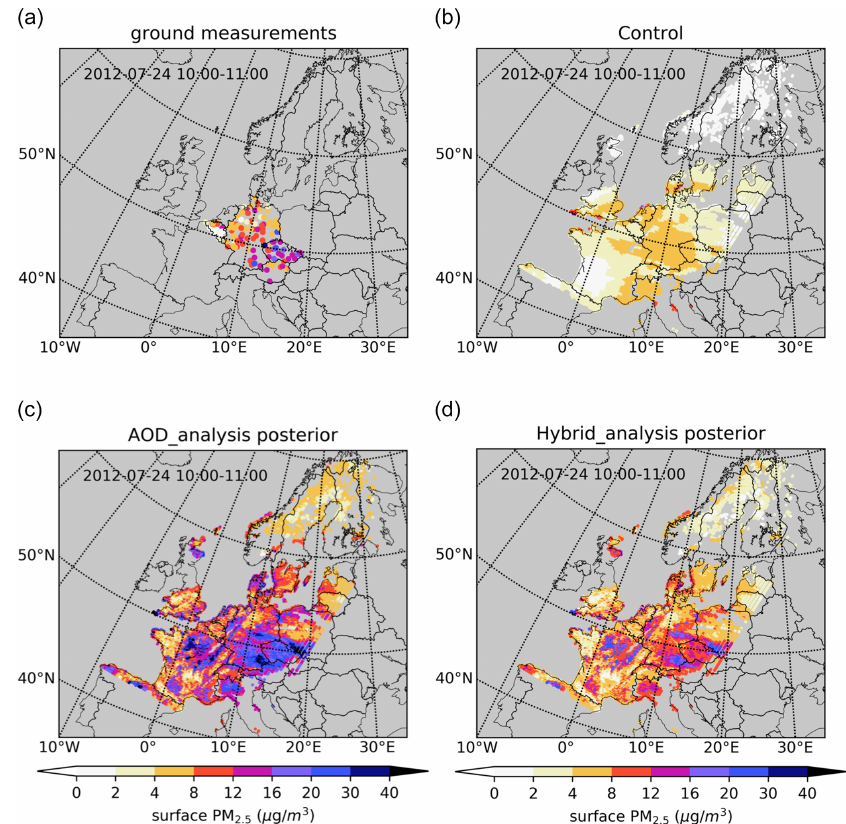
Figure 9. The surface PM 2 . 5 measurements (a) , the simulations from the control run (b) , the AOD analysis posterior (c) and the hybrid analysis posterior (d) on 24 July 2012 at 10:00–11:00UTC.